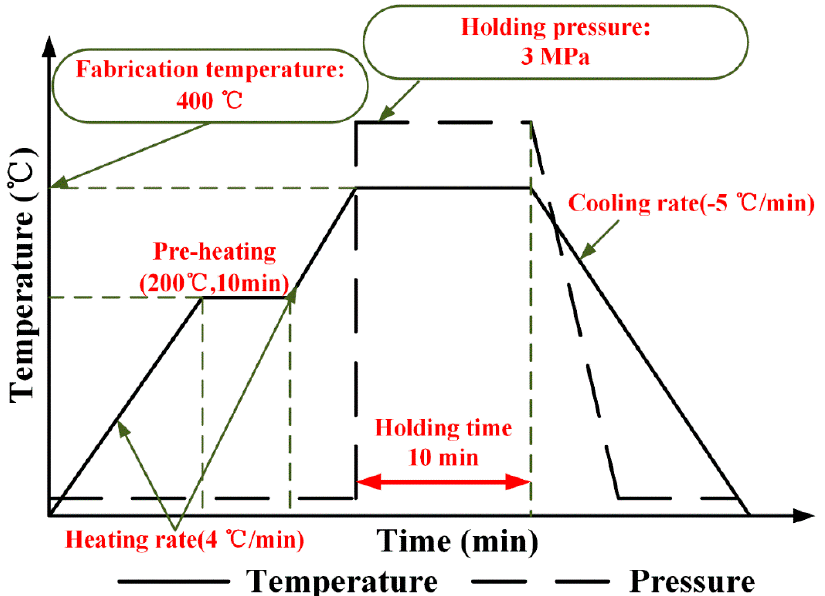
Figure 1. Compression molding process of woven CF/PEEK composite sheets.